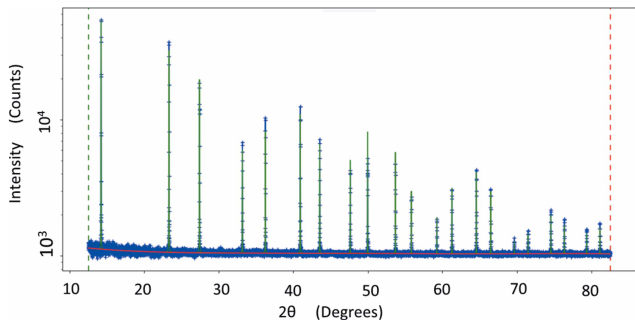
Figure 8 Silicon standard (NIST 640f) diffraction pattern at 16 keV.